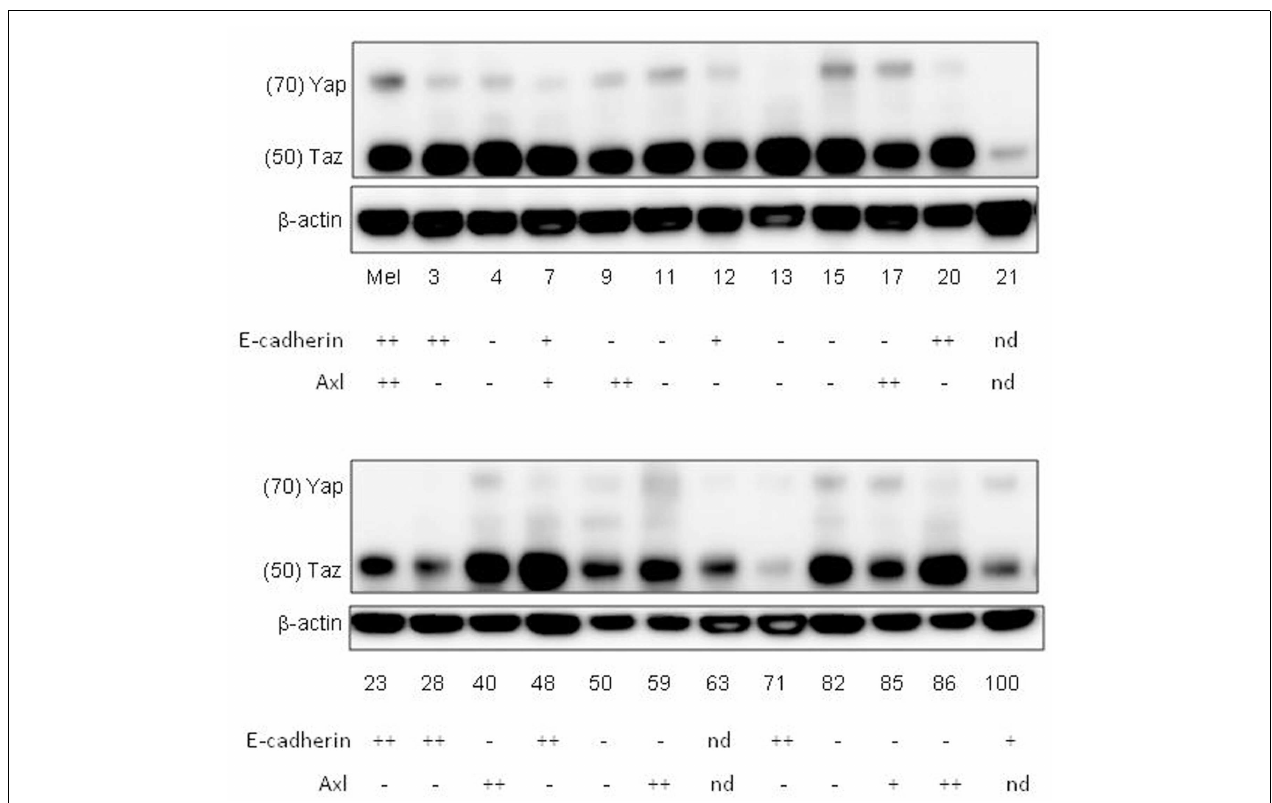
melanocytes. Data for expression on western blots of E-cadherin and Axl, taken from another publication (Kim et al., submitted), are shown below the NZM numbers; – expression not detected; + weak expression; ++ strong expression; nd not